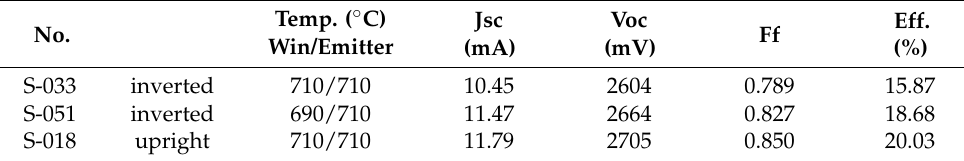
Figure 6. IQE curves ( a ) and light J–V curves ( b ) of inverted AlGaInP/AlGaAs (2.1 eV/1.7 eV) dual-junction solar cells before (red solid line) and after (blue solid line) optimization of window layer. The growth temperature is listed in Table 3. Upright AlGaInP solar cell sample grown at 710 °C (S-018) is set as benchmark (black dashed line). Table 3. Light J–V results of dual-junction solar cells (S-033, S-051 and S-018).